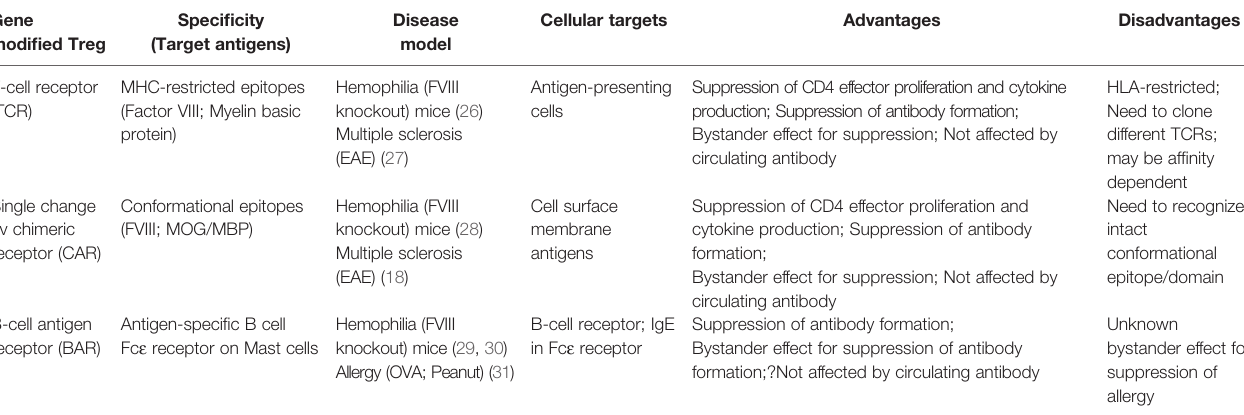
TABLE 1 | Advantages and disadvantages of engineered Treg